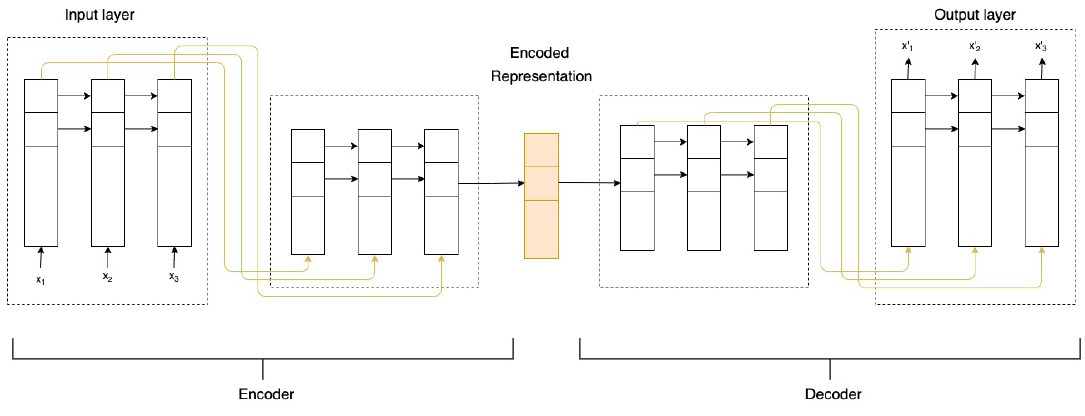
Figure 1. Illustration of the LSTM